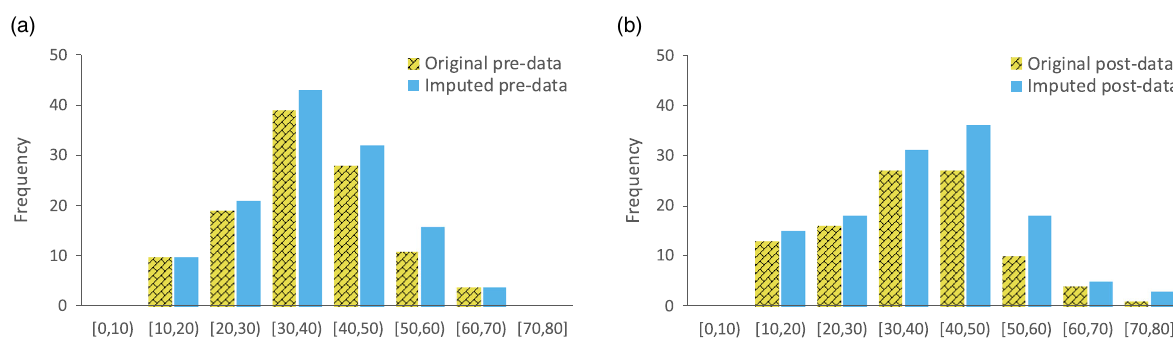
FIG. 3. Comparison of the original (yellow hatched pattern) and imputed (solid blue) data for (a) the anxiety prescores and (b) the anxiety